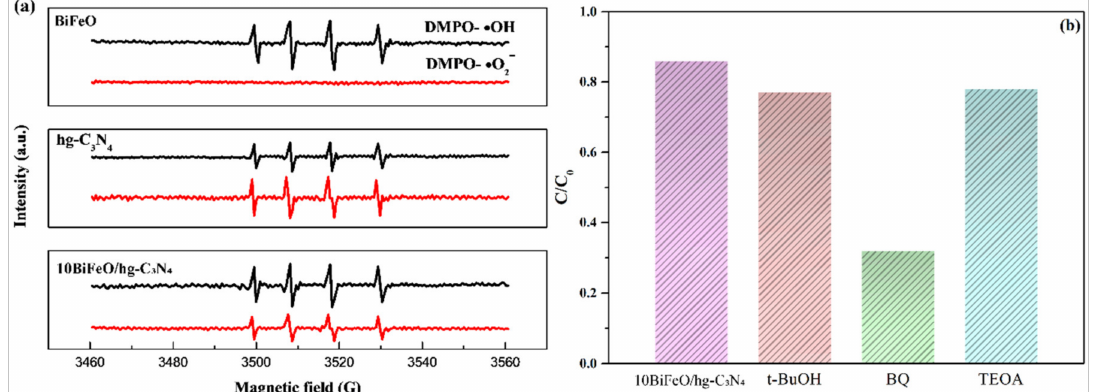
Figure 11. ( a ) ESR signals of BiFeO, hg-C 3 N 4 and 10BiFeO/hg-C 3 N 4 ; ( b ) Photocatalytic activity of 10BiFeO/hg-C 3 N 4 for the degradation of RhB in the presence of different